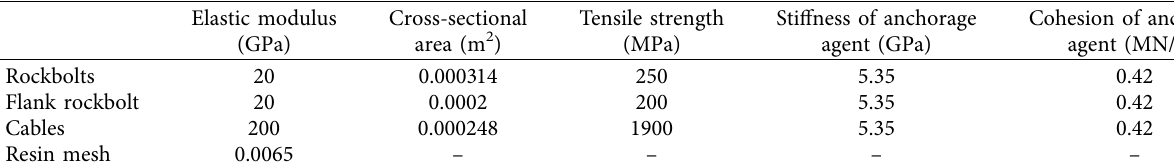
Figure 13: Plastic zone distribution of the five sections. (a) I-I. (b) II-II. (c) III-III. (d) IV-IV. (e) V-V. Table 5: Mechanical parameters of rockbolts and cables.